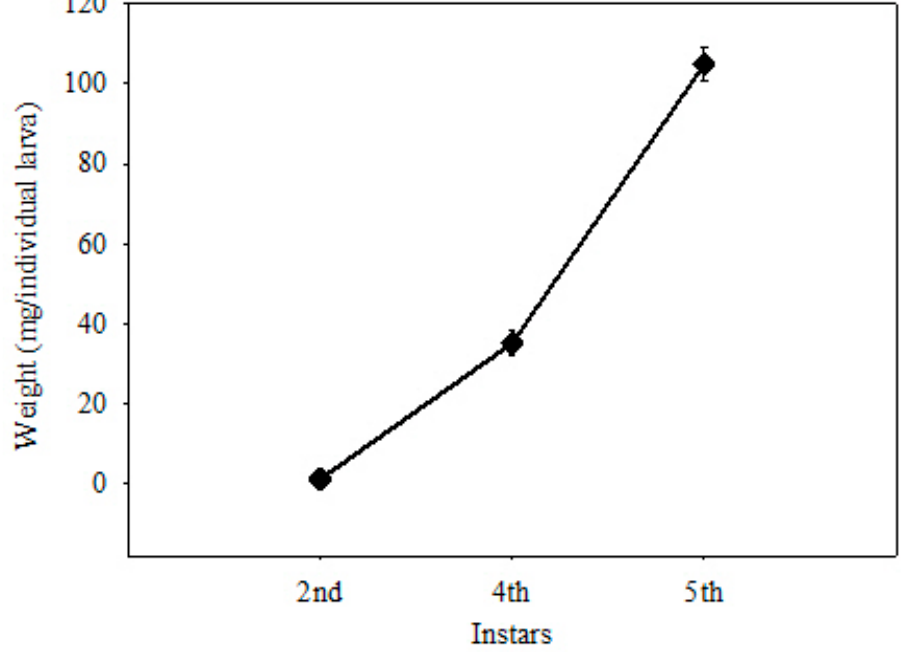
Figure 2. The changes of larva weight during larval development.